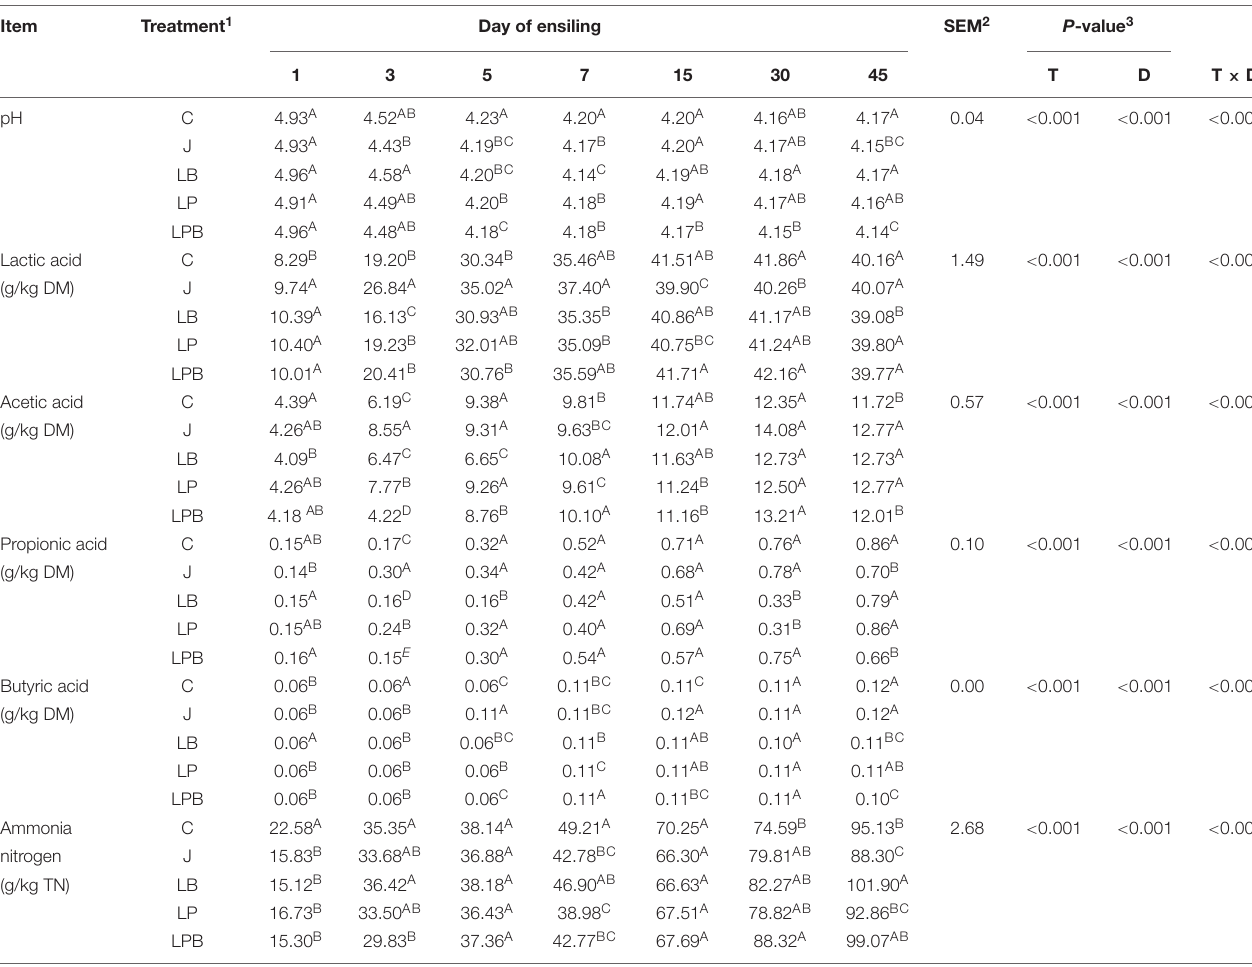
TABLE 2 | Effects of additives on fermentative characteristics of